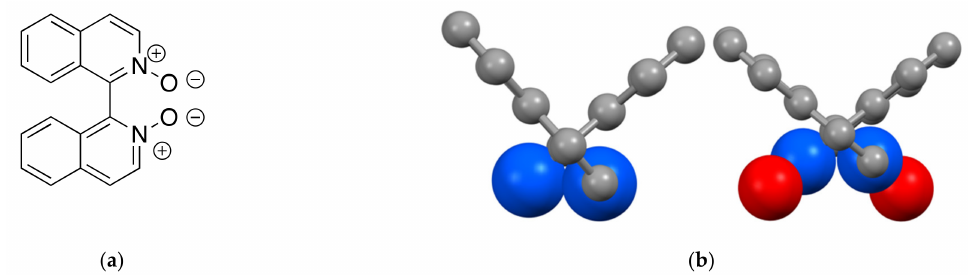
Figure 6. ( a ) 1,1 (cid:48) -Biisoquinoline N,N’ -dioxide; ( b ) in the solid state, the torsion angle N1–C1–C1 (cid:48) – N2 (cid:48) increases from 90.96 ◦ in (1 P )-1,1 (cid:48) -biisoquinoline [108] to 101.64 ◦ (1 P )-1,1 (cid:48) -biisoquinoline N,N’ - dioxide [98] showing the importance of oxygen–oxygen interactions. The nitrogen and oxygen atoms are depicted with 70% space-filling size to emphasize the stereochemistry.